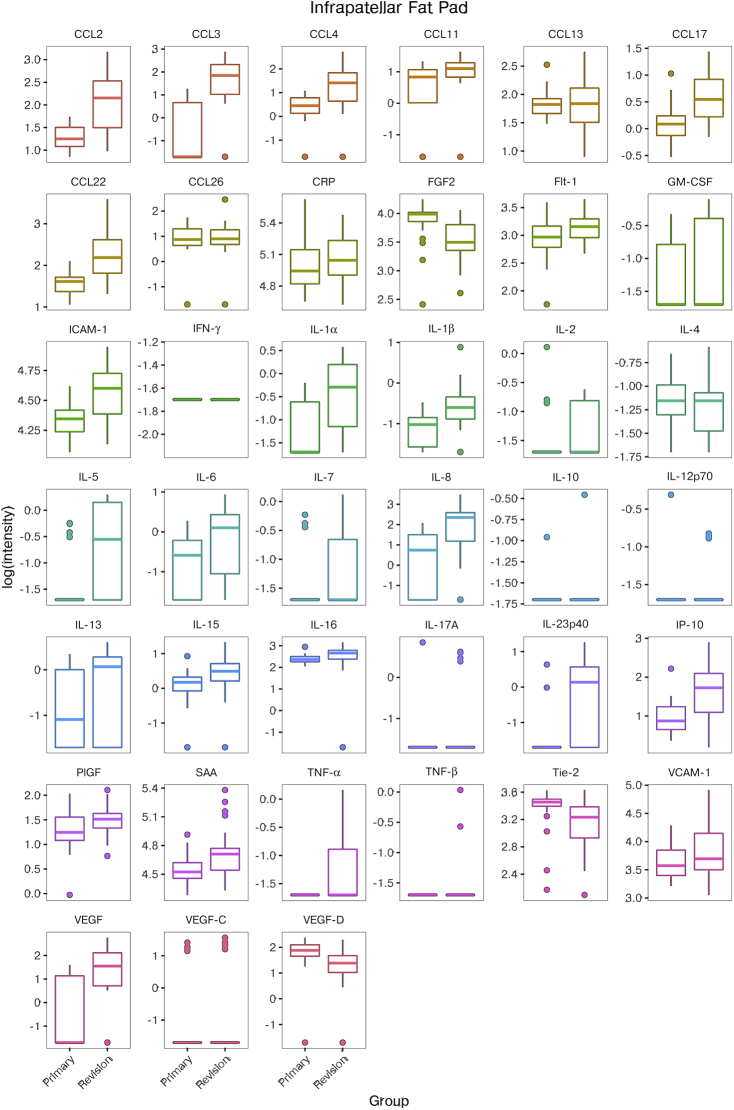
Protein expression profile of infrapatellar fat pad isolated from patients undergoing primary and revision total knee arthroplasty. Data are presented as box-and-whiskers plot. CRP, C-reactive protein; FGF, fibroblast growth factor; Flt, Fms-like tyrosine kinase 1; GM-CSF, granulocyte-macrophage colony-stimulating factor; ICAM, intercellular adhesion molecule; IFN, interferon; IP-10, interferon gamma-induced protein 10; PIGF, placental growth factor; SAA, serum amyloid A; Tie, tyrosine kinase; TNF, tumor necrosis factor; VCAM, vascular cell adhesion molecule; VEGF, vascular endothelial growth factor.